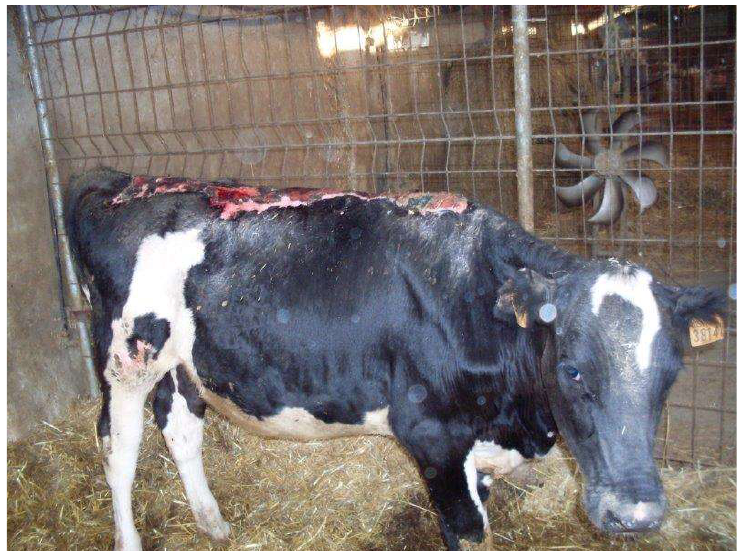
Figure 2. Heifer 2 at first clinical examination, which showed quadrupedal station and alert demeanor. Note the skin lesion on the back.